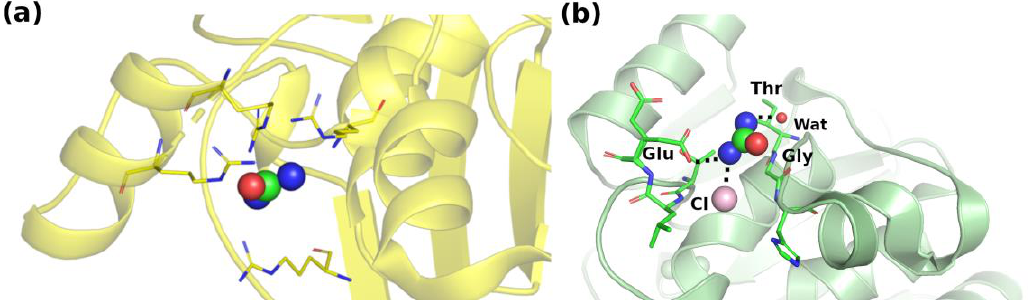
Figure 3. Interaction network where urea makes ( a ) multiple types of contacts with arginines (PDB ID: 5ulp [36]), and ( b ) multiple main-chain and side-chain H-bonds (PDB ID: 5i4y [37]). For clarity, interacting water molecules are omitted in ( a ).